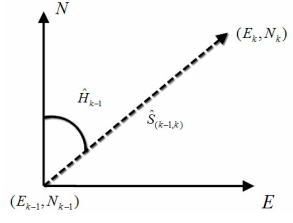
Figure 1. Illustration for the PDR